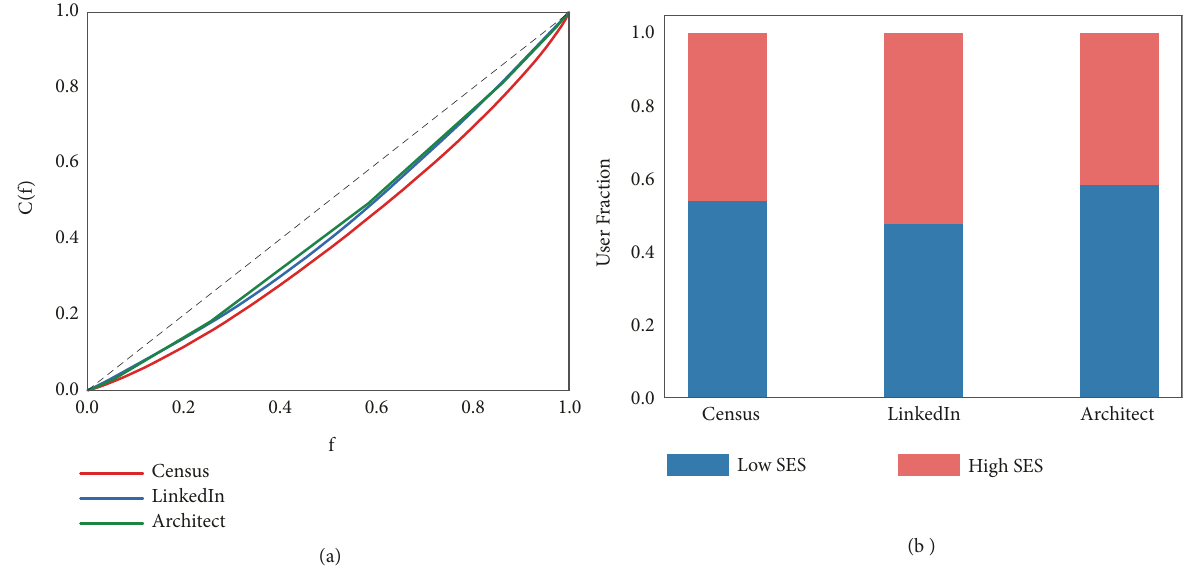
Figure 6: Cumulative distributions of income as a function of sorted fraction 𝑓 of individuals. Dashed line corresponds to the perfectly balanced distribution. Distributions appear similar in spite of dealing with heterogeneous samples.